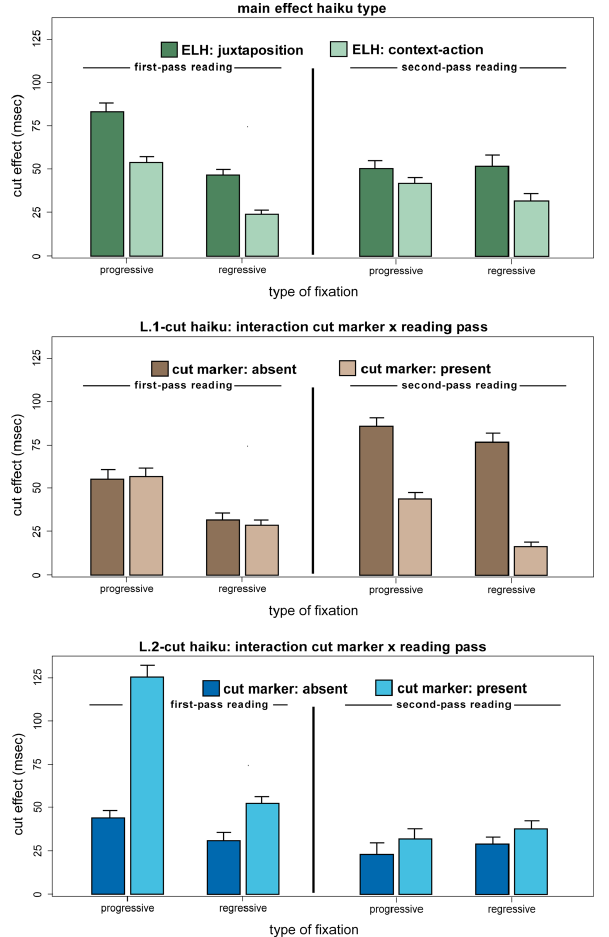
Figure 4 . Cut effects (fragment line minus [remote] phrase line reading times, in milliseconds) as a function of progressive vs. regres- sive fixations in first- vs. second-pass reading. The three panels show re-/reading differences arising from different semantic-conceptual ELH properties (juxtaposition vs. context–action haiku; top panel) and different formal-structural ELH properties (non-/use of cut markers in L.1- vs. L.2-cut haiku; middle and bottom